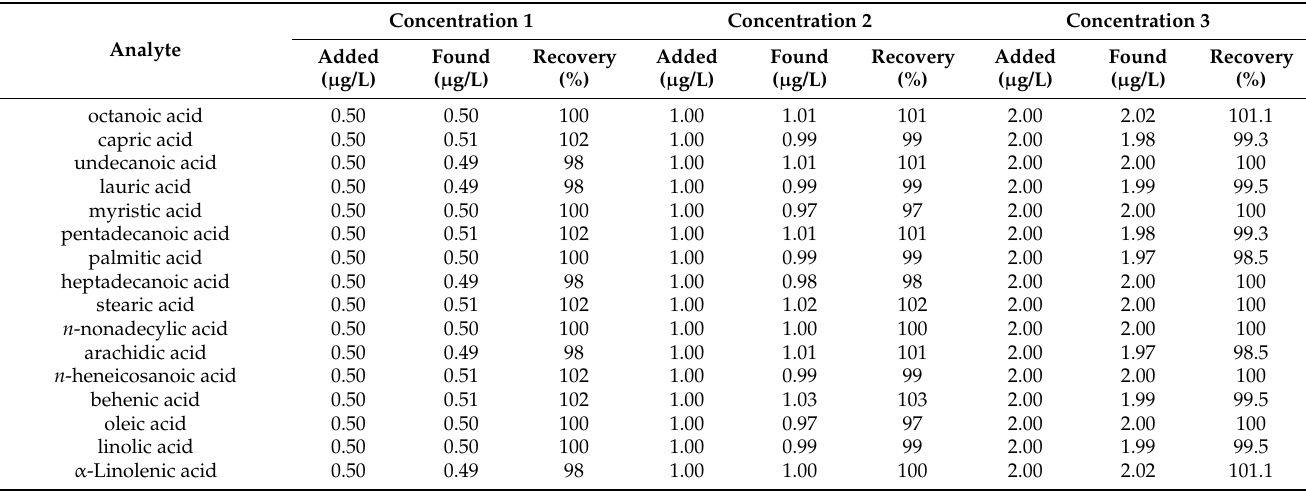
Table 6. Recovery studies of the proposed method at three concentration